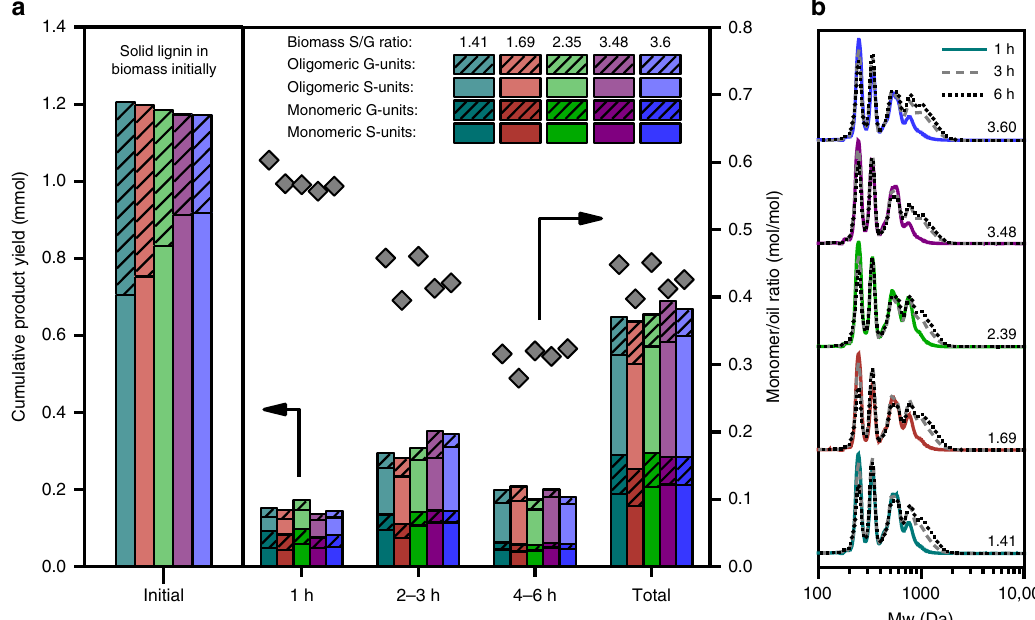
Fig. 3 Characterization of the oligomeric fraction of lignin oil produced from fl ow-through RCF. a Mole balance of S and G aromatic units in the monomeric and oligomeric species in lignin oil. The molar monomer-to-oil ratio, which is a measure of lignin fractionation and depolymerization. b GPC of the lignin oils from different biomass samples at different RCF extraction